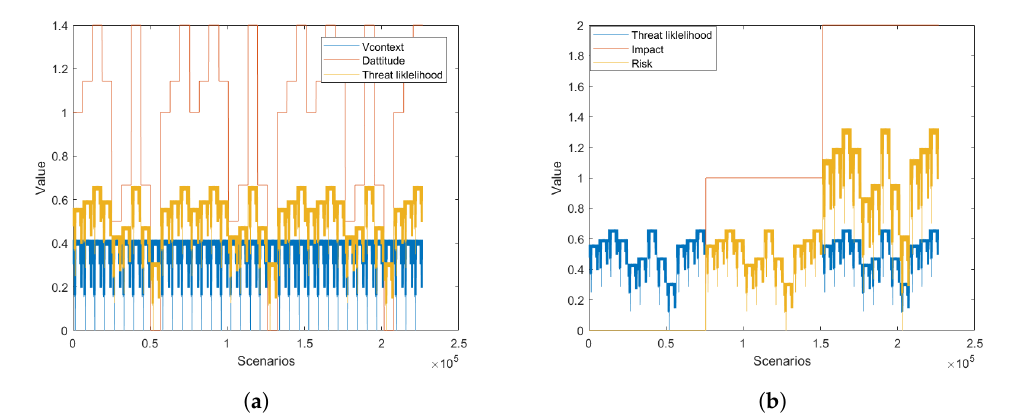
Figure 13. Theoretical risk analysis. ( a ) Threat likelihood for each scenario; ( b ) Risk estimation for each